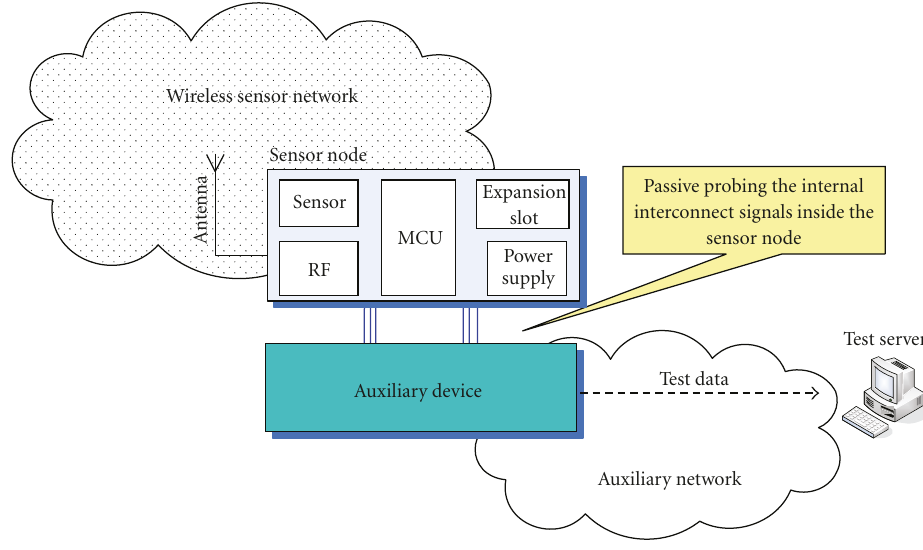
Figure 5: The mechanisms of HINT.